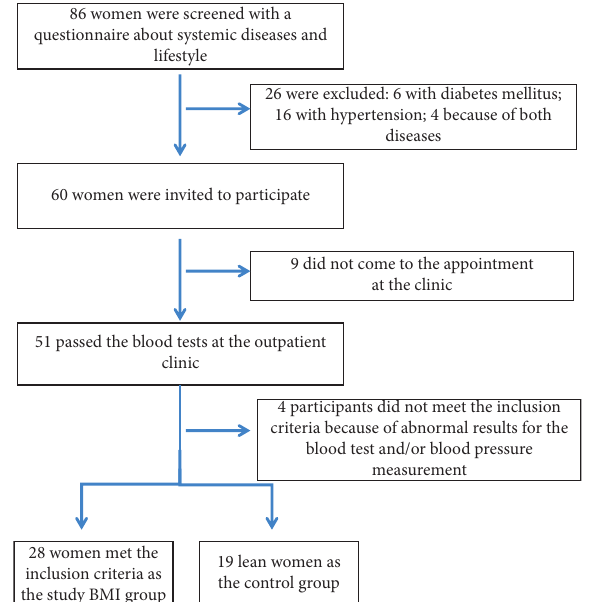
Figure 1: Flowchart diagram of participant sampling, recruitment, and exclusion